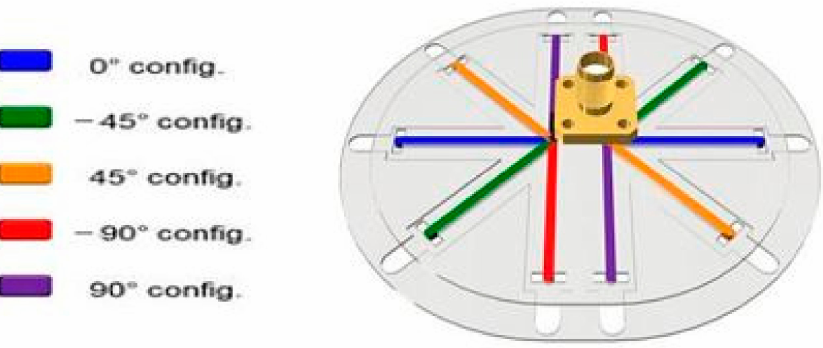
Figure 27. Polarization and pattern reconfigurable dipole antenna [41].